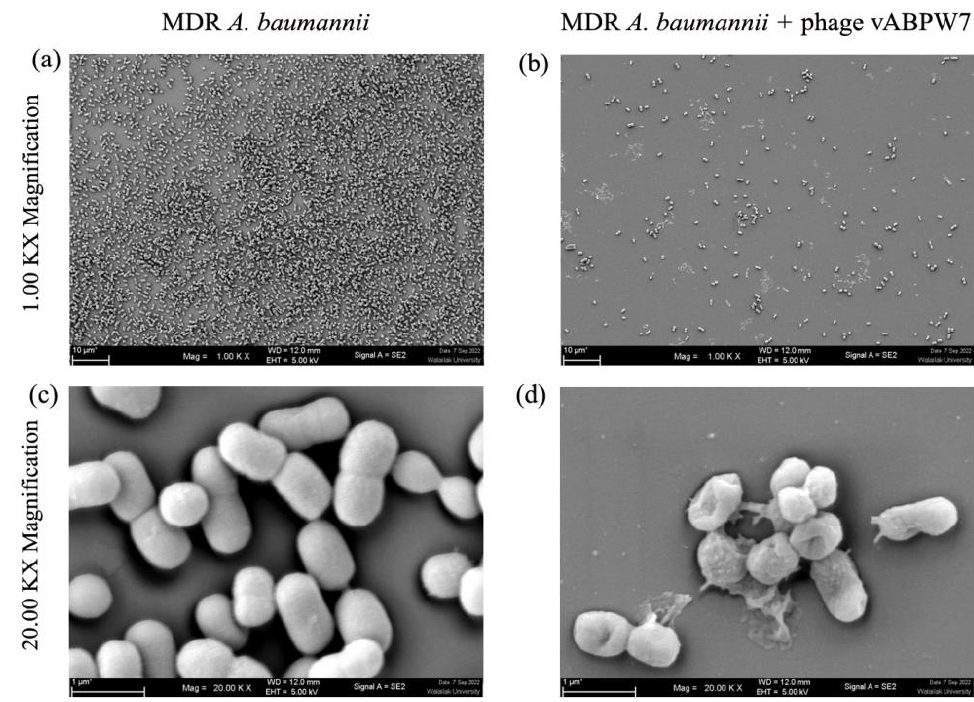
Figure 2. Morphology of MDR A. baumannii cells under FE-SEM. ( a , c ) Untreated MDR A. baumannii cells. ( b , d ) MDR A. baumannii infected with phage vABWU7. The cells were observed at magnifications of × 1000 and × 20,000.